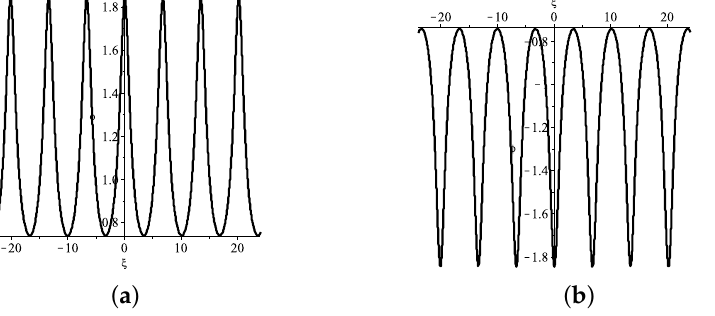
Figure 25. Periodic wave forms of system (5). ( a ) Defined by (64) + . ( b ) Defined by (64) − . G ( φ ) =